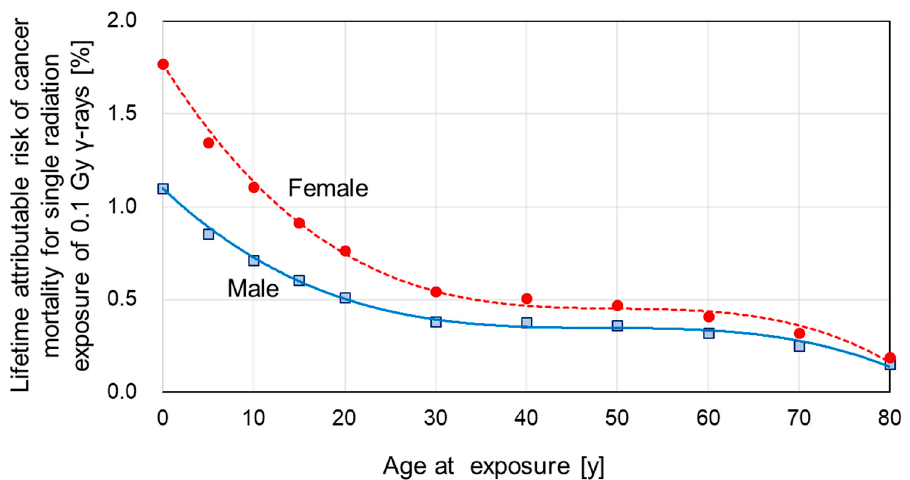
Figure 1. Lifetime attributable risk of radiation-induced cancer mortality as a function of age at exposure for male (solid line) and female people (dotted line) (after the BEIR VII report [10]).